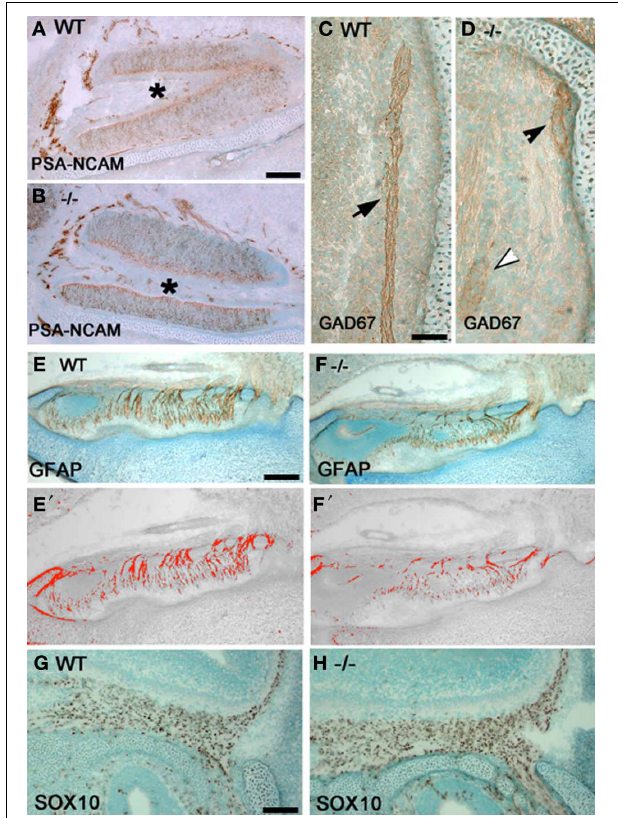
FIGURE 4 | Olfactory fiber and OECs changes in p75NGFR − / − mice. Sagittal sections close to midline of a p75NGFR − / − (B,D,F,H) embryo and WT littermates (A,C,E,G) showing an area of VNO (A,B) and nasal forebrain junction (C,D,E–H) . Sections were immunostained for markers of olfactory axons—PSA-NCAM (A,B) and GAD67 (C,D) , and for OECs—GFAP (E,F) and SOX10 (G,H) . (E (cid:3) –F (cid:3) ) are representative transformed images corresponding to (E) and (F) , respectively, and were used for measurement of olfactory fiber density; similarly transformed images (not shown) were used in optical density measurement for Sox10 positive cells in (G) and (H) . Optical density values from structures other than the fibers were subtracted from the total measurements. (A,B) PSA-NCAM-immuostained fibers around the VNO have similar pattern and intensity between WT (A) and -/- (B) animals. (C,D) GAD67 staining intensity in WT control animals is strong ( C , brown, arrow); whereas, variable staining pattern observed in − / − mice (D) , from weak (white arrowhead), moderate (black arrowhead) to absent. (E,F) Optical density measurement of GFAP-positive fibers in NFJ showed significant reduction in fiber density of p75 − / − mice compared to its WT littermates. (G,H) Optical density measurement of OECs in the NFJ showed increase in staining intensity in -/- mice but cell counts were similar with WT animals. Scale bars: 250 μ